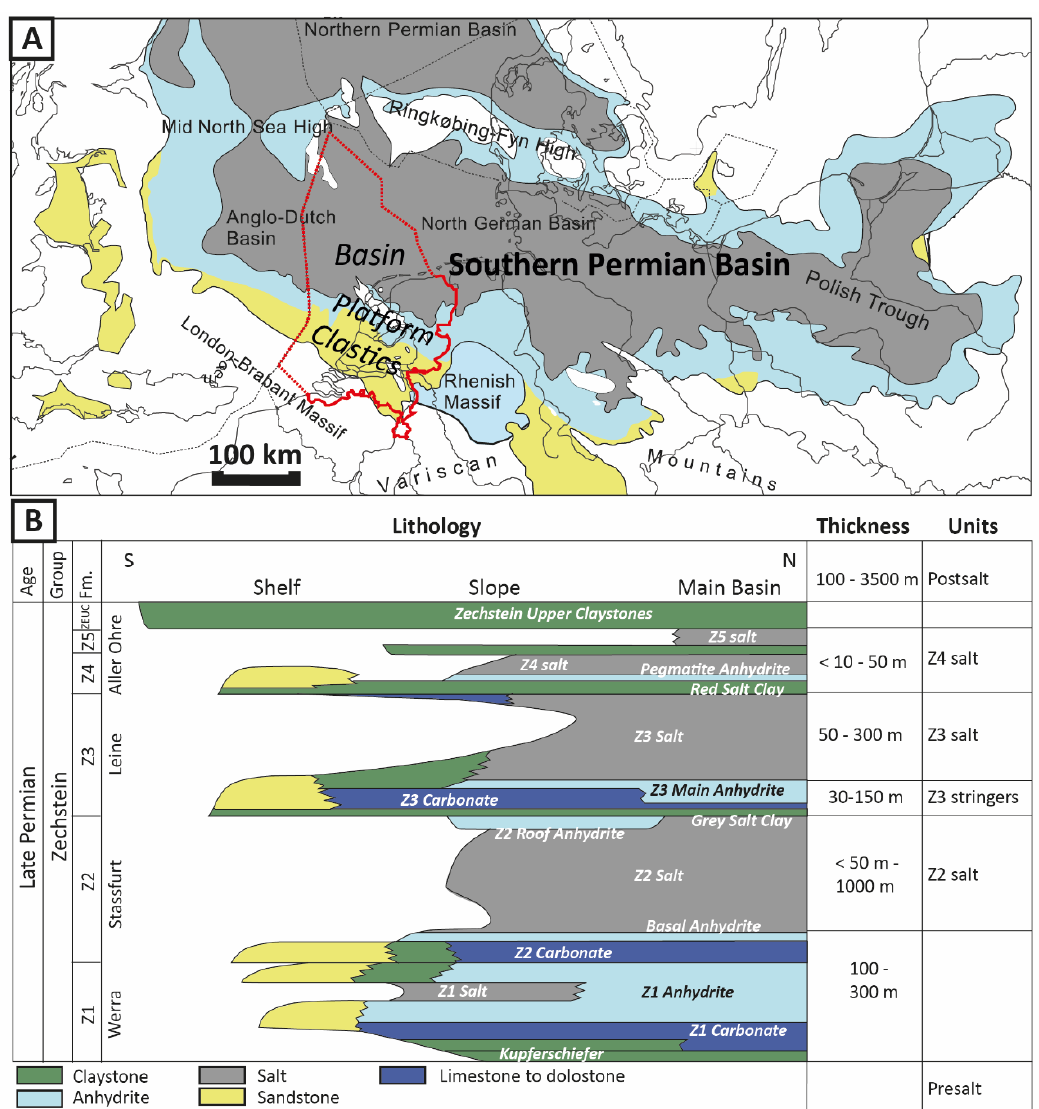
Figure 1. ( A ): Facies map of the Zechstein group (Z2 Carbonate) in the Southern Permian Basin (after [4] and reference therein) and localization of the Netherlands onshore and offshore domain (red line). ( B ): General lithostratigraphic chart of the Zechstein in Netherlands (after [14]).